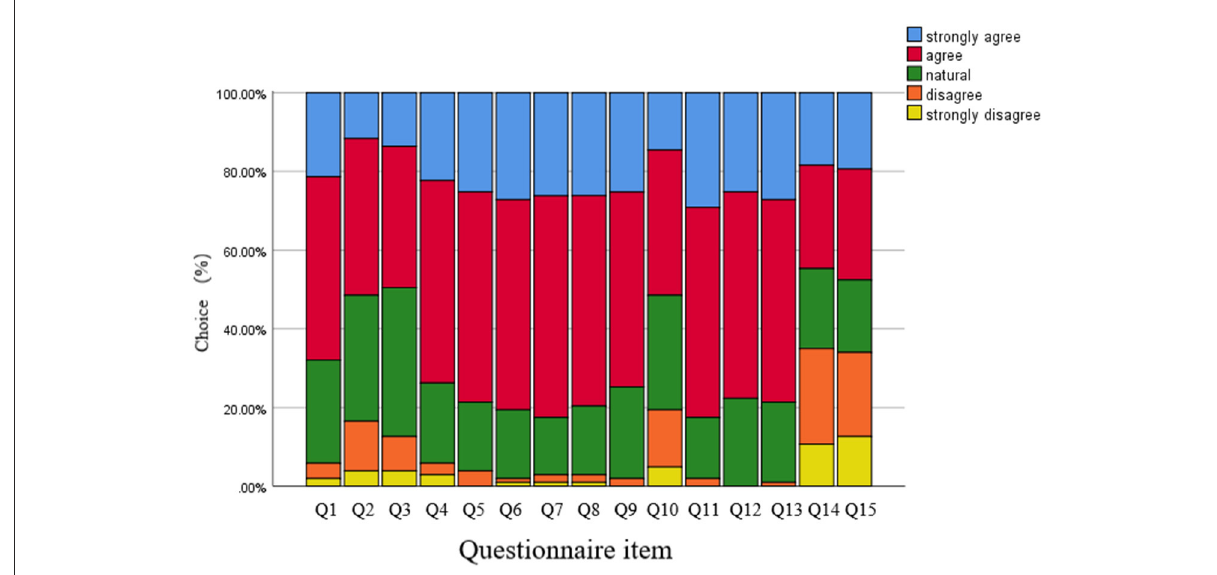
FIGURE2 Results of the student evaluation questionnaires regarding the artificial intelligence based grading system. Each survey question used a five-point scale. For details of the questionnaire, see the Table